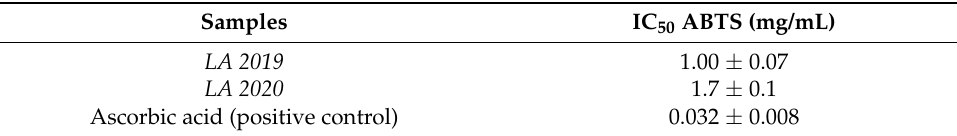
Table 3. Antioxidant activity of L. angustifolia essential oils.